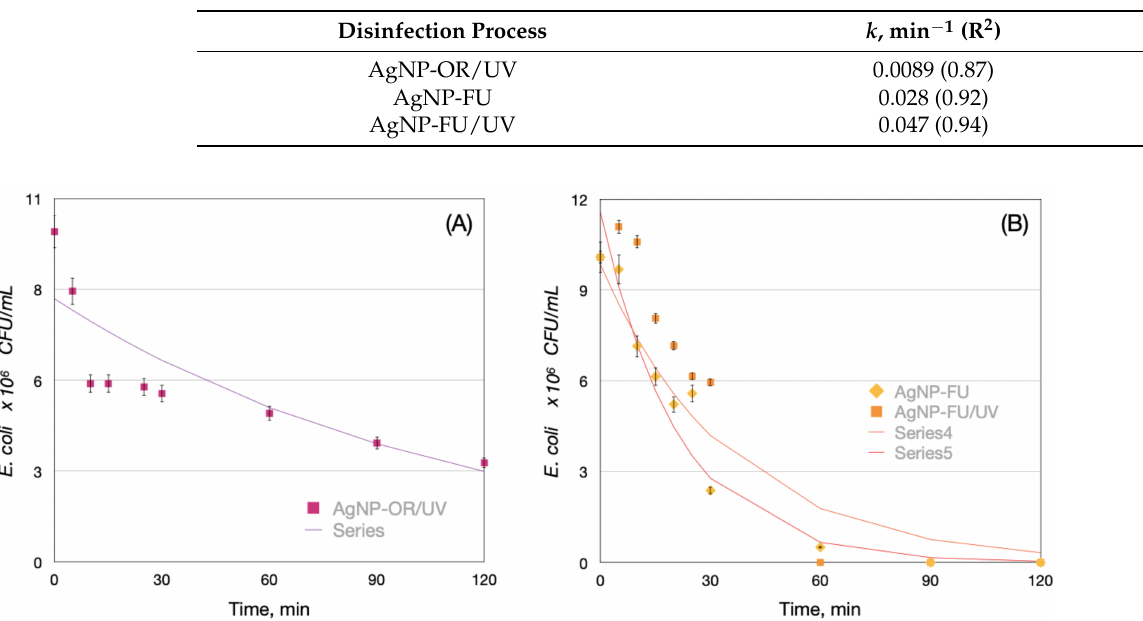
Figure 4. Simulation of the experimental results using Chick’s law model for two types of silver nanoparticles used in E. coli disinfection: ( A ) AgNP-OR with UV light, and ( B ) AgNP-FU and AgNP-FU with UV